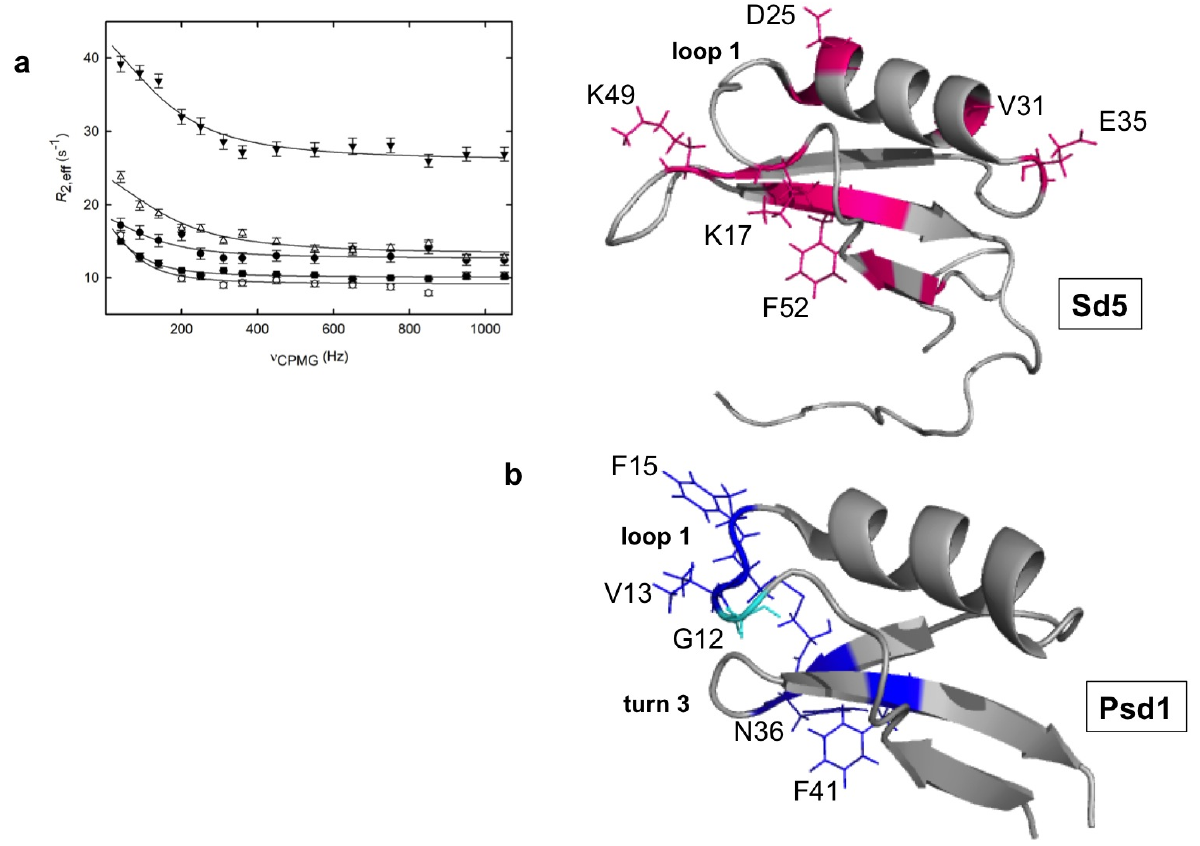
Figure 5. Dynamics properties of the plant defensins Sd5 and Psd1. Quantitative analysis of exchange dynamics in Sd5. 15 N-NMR relaxation dispersion curves were measured at 800 and 600 MHz. Side chains of the residues with amide backbone conformational exchange measured by NMR relaxation dispersion are colored magenta in the NMR structure of Sd5 (PDB code 2KSK) ( a ). Ribbon representation of Psd1 highlighting the side chains of the residues in conformational exchange in blue and the flexible hinge Gly12 in cyan. Gly12 is the only residue with decreased order parameter, which indicates thermal flexibility (PDB code 1JKZ) ( b